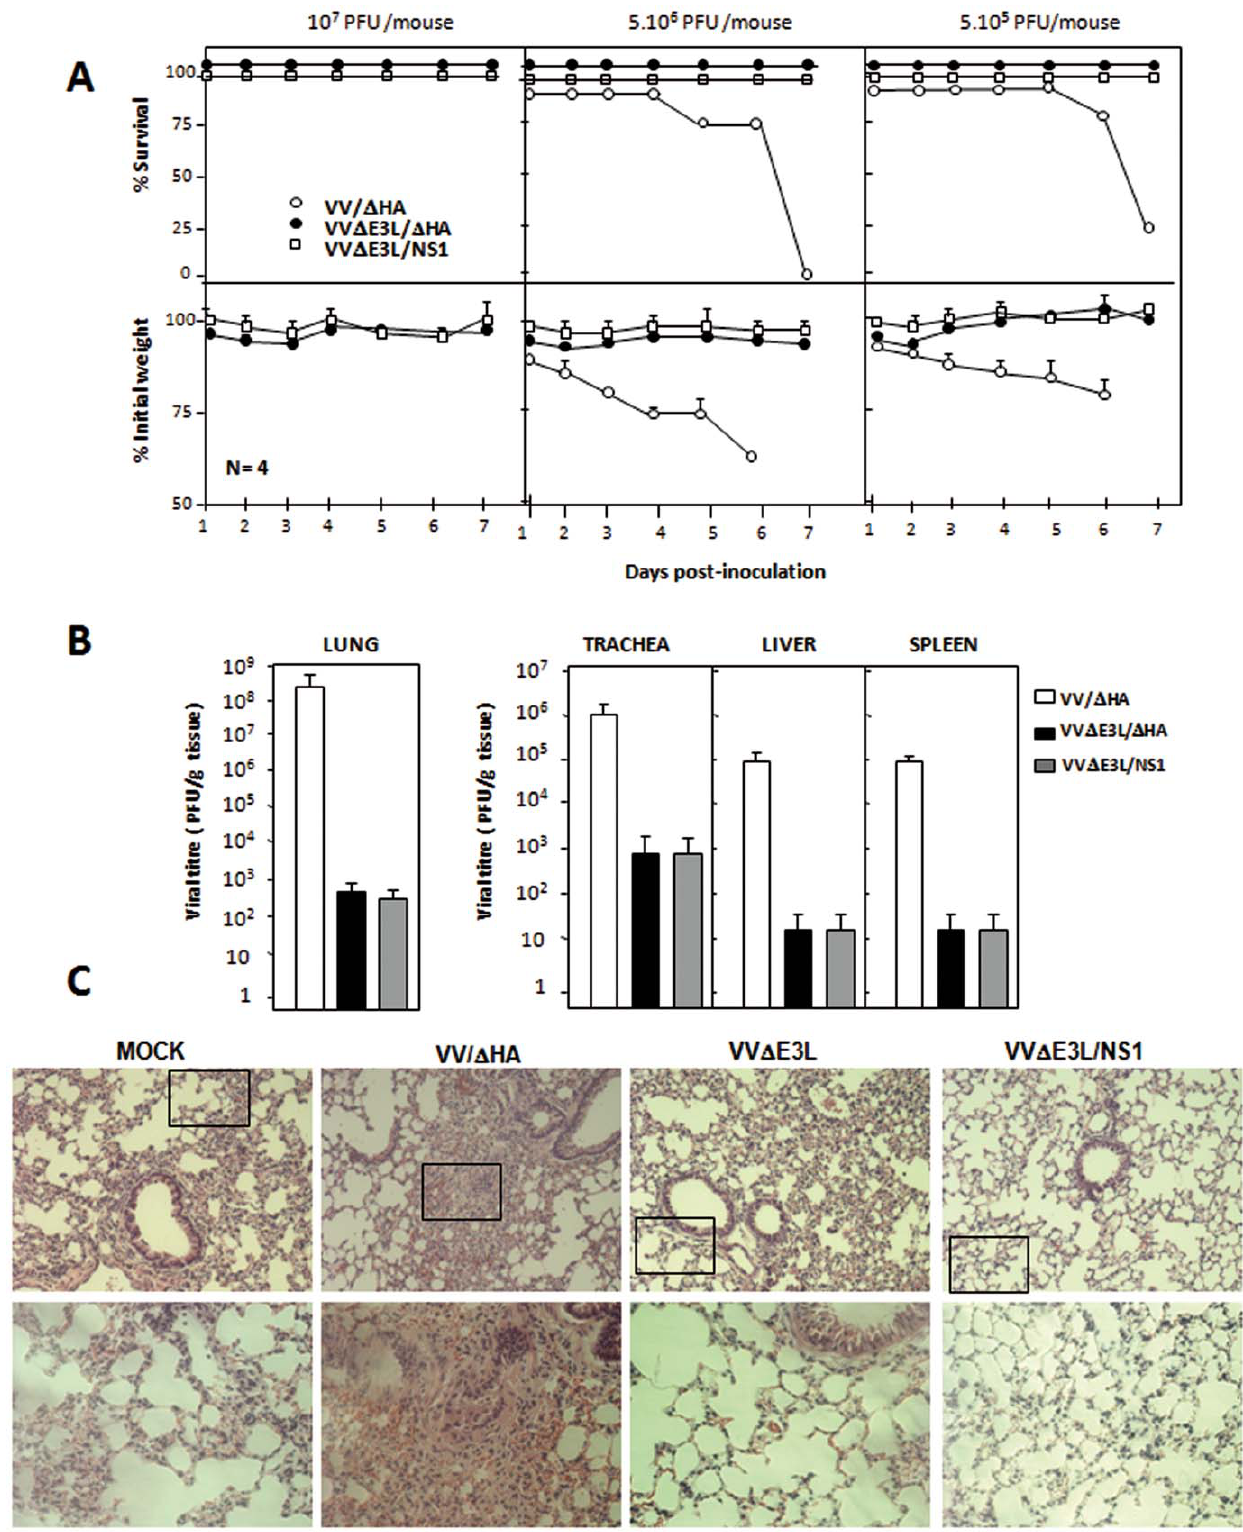
Figure 4. The expression of influenza virus NS1 protein does not modify the attenuated phenotype of VV D E3L invivo . A. C57/BL6 mice were infected i.n. with three doses of VV D E3L/ D HA or VV D E3L/NS1, (10 7 , 5 6 10 6 or 5 6 10 5 PFU/mouse) and two doses of VV/ D HA (5 6 10 6 or 5 6 10 5 PFU/mouse). Weight and survival rates were monitored. Survival curves are shown in the upper panels. The percentage of weight loss of each animal with respect to the initial weight at the starting of the experiment was calculated, and the mean values of four animals per group are represented (lower panels). The error bars represent standard deviation. B. Quantitative analysis of viral replication in the lung, trachea, liver, and